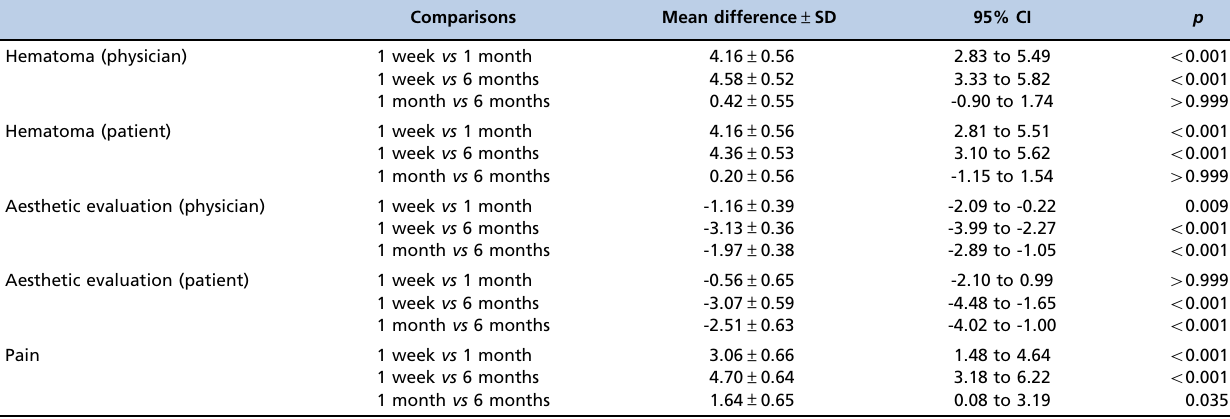
Table 3 - Comparison between the different moments studied for hematoma, aesthetic result, and